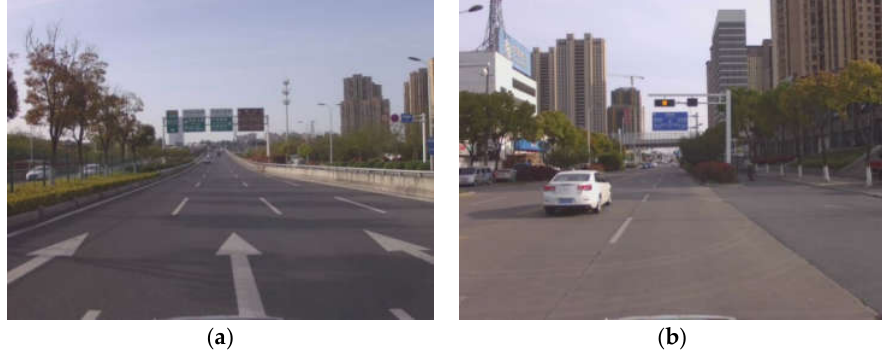
Figure 19. Test site at daytime: ( a ) city expressway; ( b ) ordinary urban road.